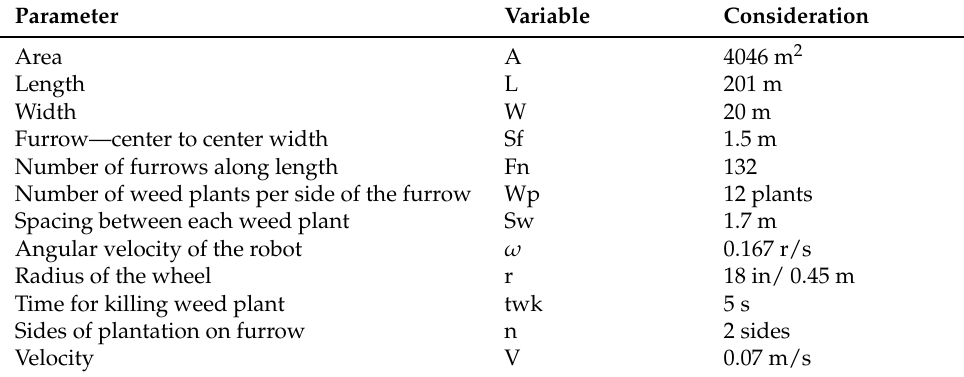
Figure 7. Surface irrigation system design using WinSRFR simulation model. Table 1. Details of farm field in